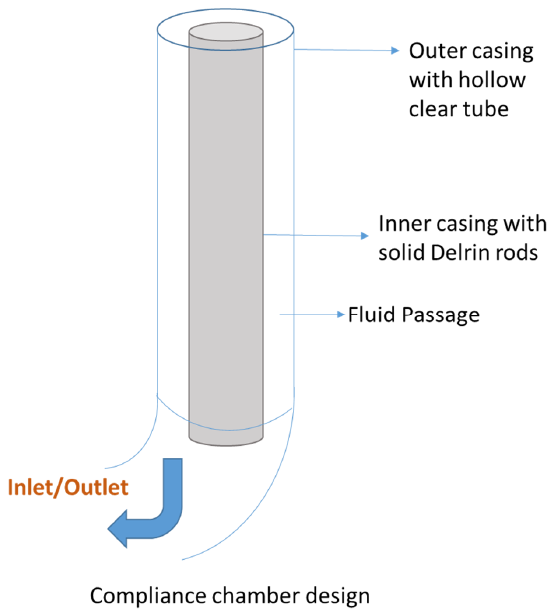
Figure 3. Design of annular compliance chamber replicating the vascular compliances.